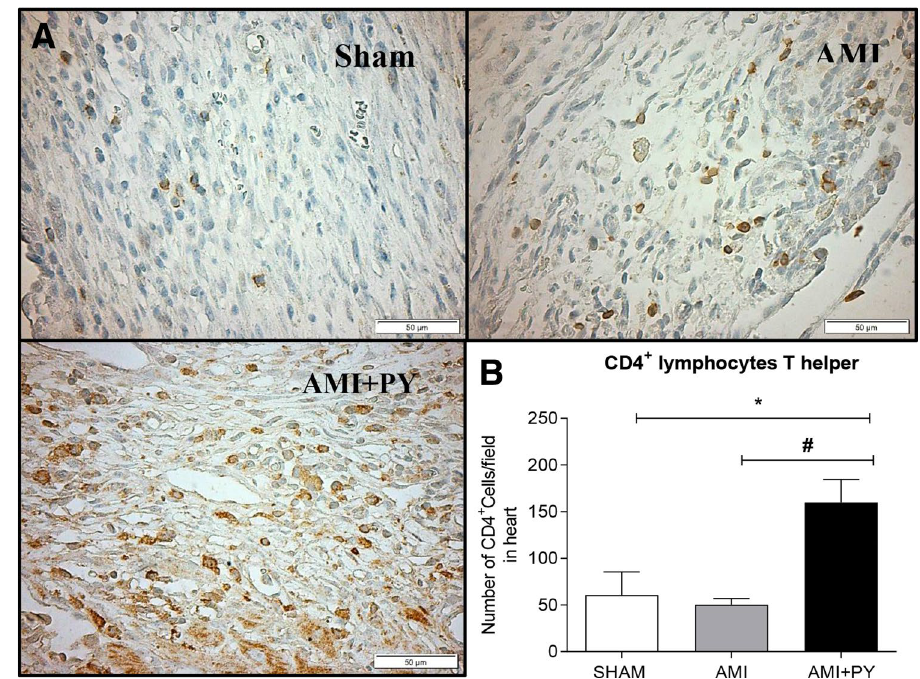
Figure 7. CD4 + cell count (Lymphocytes T helper) ( A ). Photomicrographs showing the Lymphocytes T helper within the infarcted zone from the left ventricle (magnification 400×) and (B) bar graphs of CD4 + positive cells in each group was compared. Fifteen microscopic fields of the infarcted and peri-infarcted zones were analyzed (5–6 animals per group). * P < 0,05; # P < 0.05 statistically significant. * AMI + PY versus Sham; # AMI + PY versus AMI. (Immunohistochemistry, diaminobenzidine: scale bar equals 50 µm). Values expressed as mean ± SEM. Statistical significance was determined by one-way ANOVA followed by a multiple comparisons test Tukey’s was performed using GraphPad Prism version 9.0.1. www. graph pad. com.